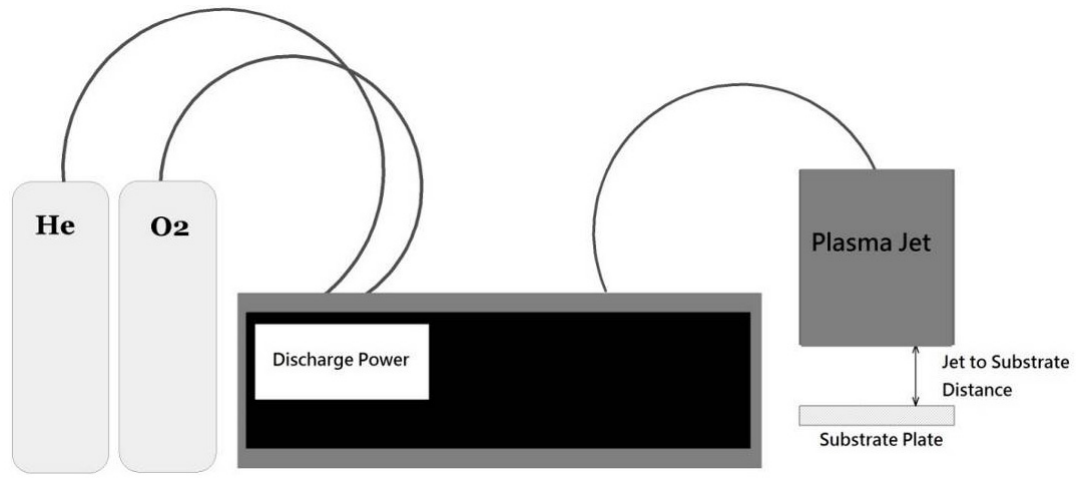
Figure 1. Schematic diagram for atmospheric pressure plasma treatment. Table 1. Operational parameters settings for plasma treatment.